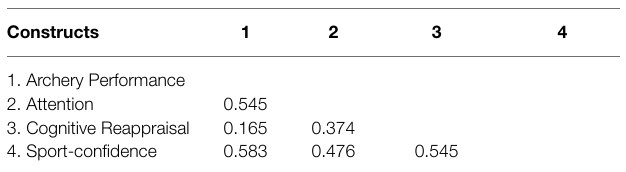
TABLE 4 | Heterotrait–monotrait (HTMT)